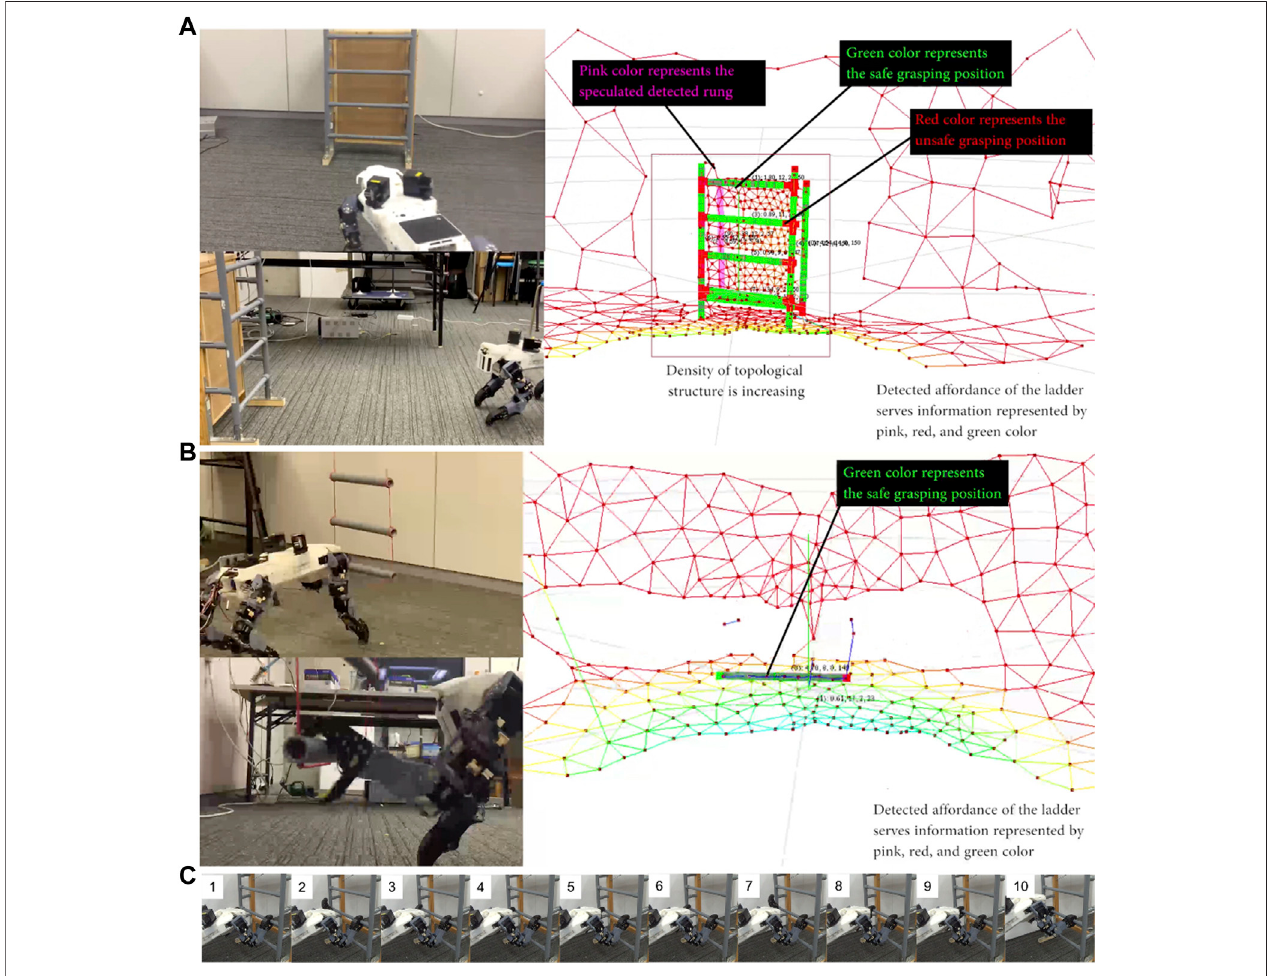
FIGURE 14 | (A) The robot detects the ladder ’ s affordances while approaching it. (B) Robot detects graspability of a swinging ladder and grasps a rung of the moving ladder. (C) The snapshot video of the robot performance detailed in the link of Video 5 . The robot approaches and climbs a ladder, then transitions back to a horizontal posture to stand on the tabletop (frames 9 –